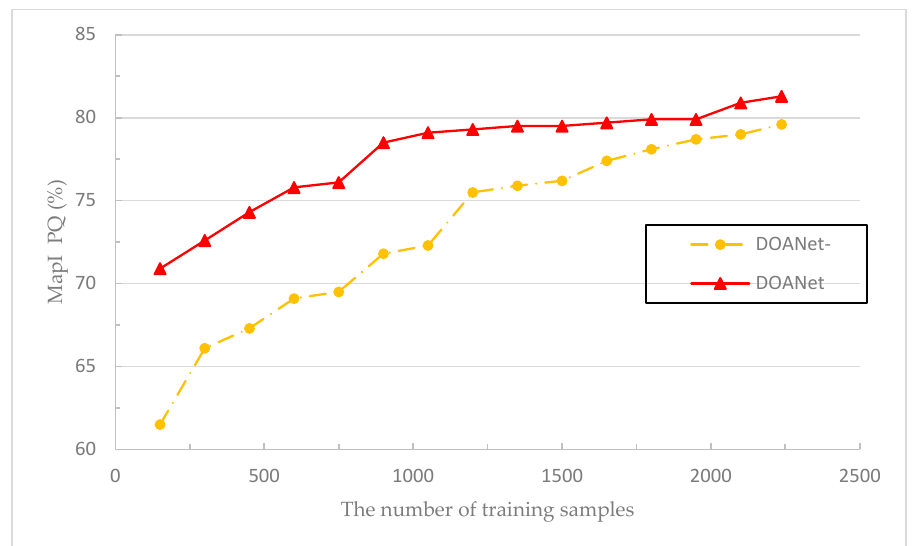
Figure 9. The number of training samples compared to scores.